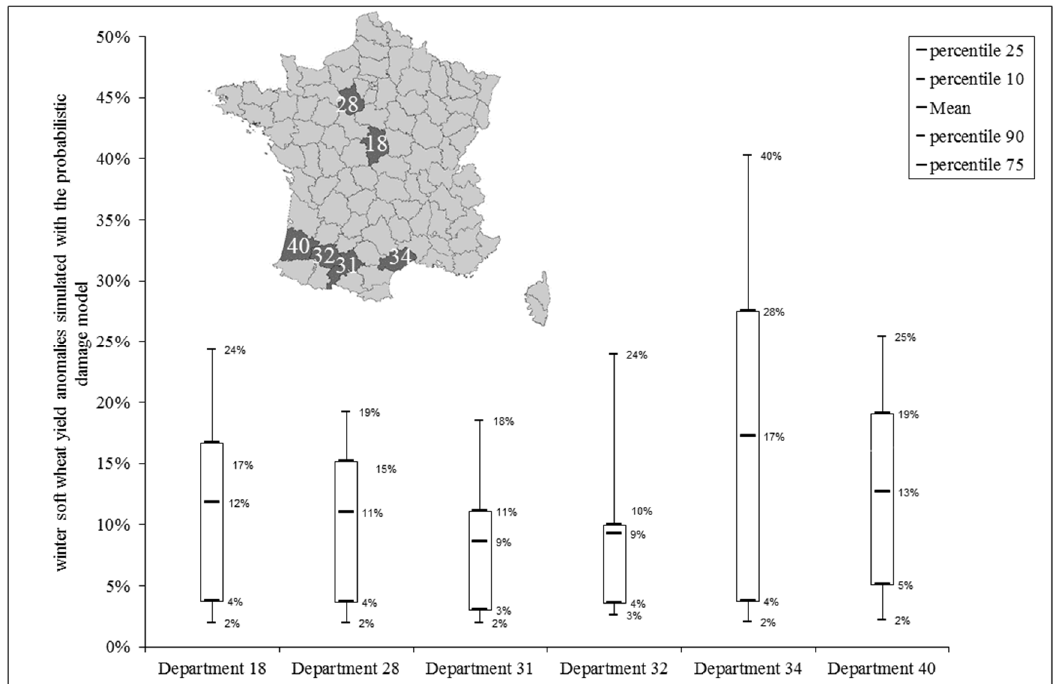
Figure 7. Simulated yield anomalies caused by drought for winter soft wheat simulated with the probabilistic model. Department 34 is characterized by a Mediterranean climate, department 31, 32, and 40 by a southern oceanic climate, and department 18 and 28 by a northern modified oceanic